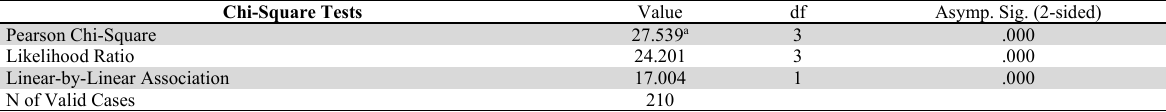
(Source: The survey data of the